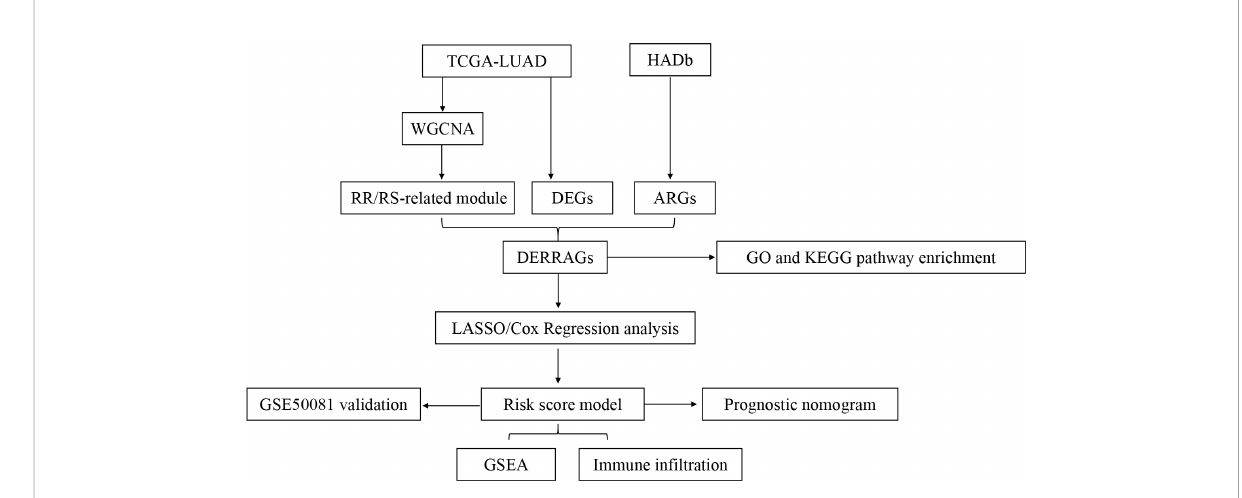
FIGURE 1 Flowchart of the comprehensive analysis process in the present